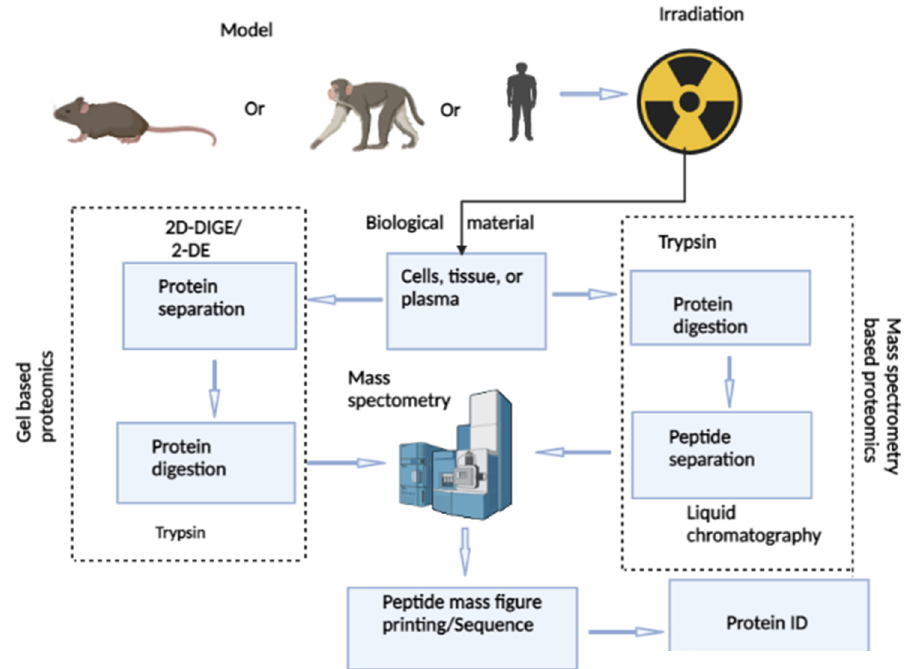
Figure 1. Flow-chart showing the steps involved in intestinal proteomics analysis for gel-based and mass spectrometry-based methods. Briefly, lysates from cells in culture or tissues of rodents and nonhuman primates or plasma from nonhuman primates and humans collected after irradiation are subjected to one of two protein separation methods, gel or mass spectrometry. Subsequently, peptide spectra and corresponding mass to charge ratios are generated by mass spectrometry, searched against protein databases for protein identification and further downstream analysis.